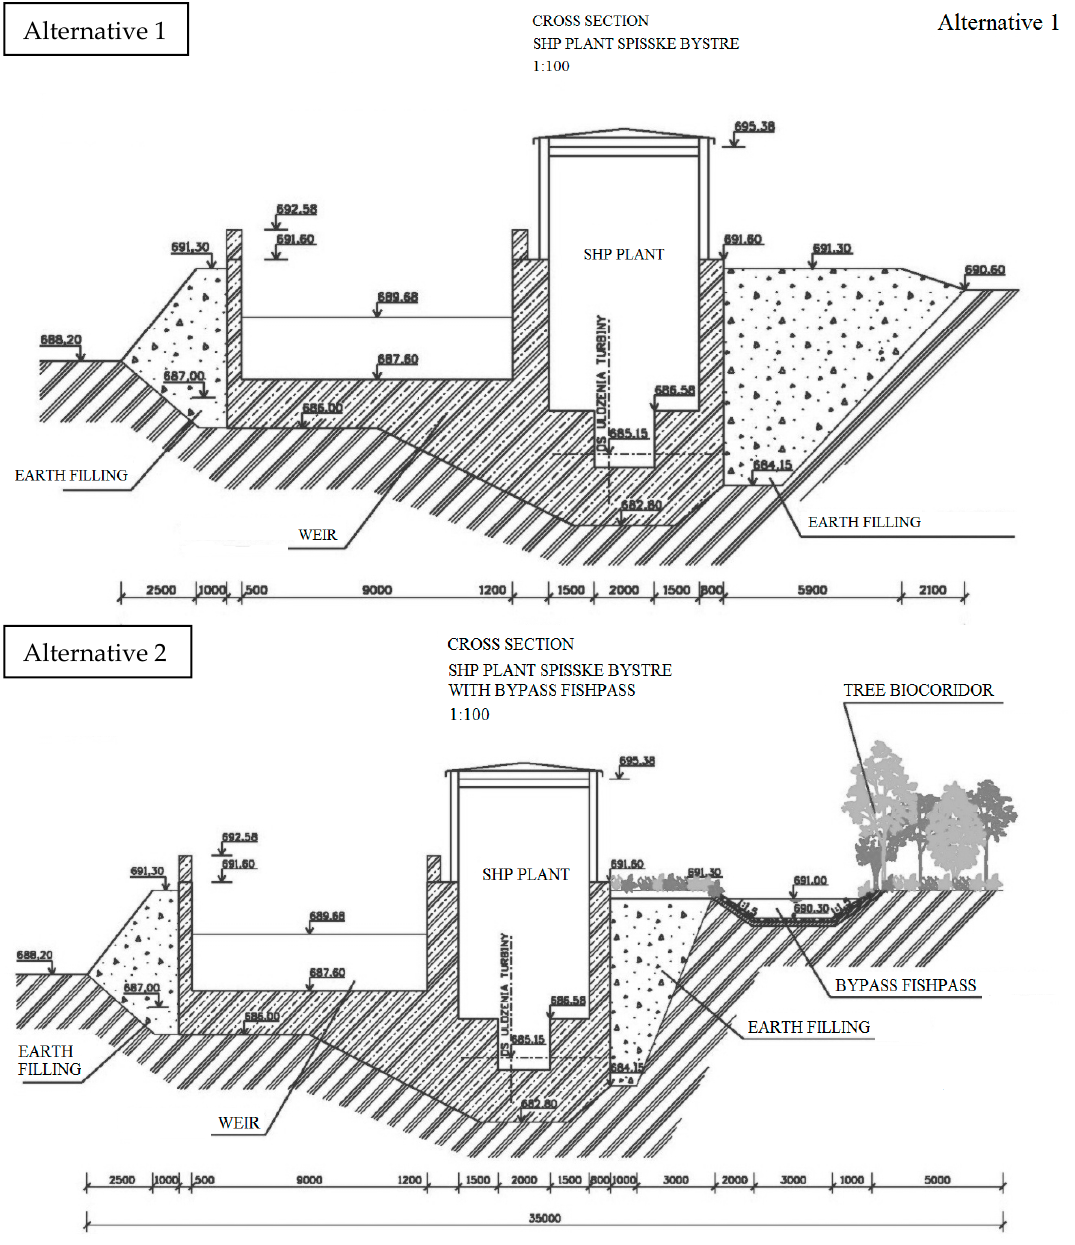
Figure 2. Alternatives of the proposed activity.